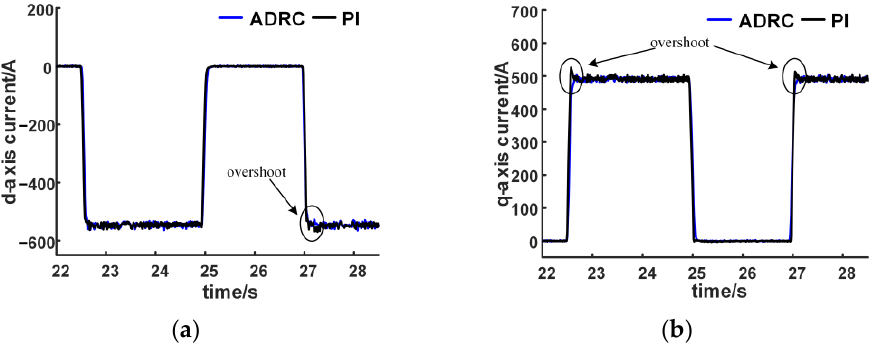
Figure 7. Peak torque step response(200 r·min −1 ): ( a ) d-axis current; ( b ) q-axis current.